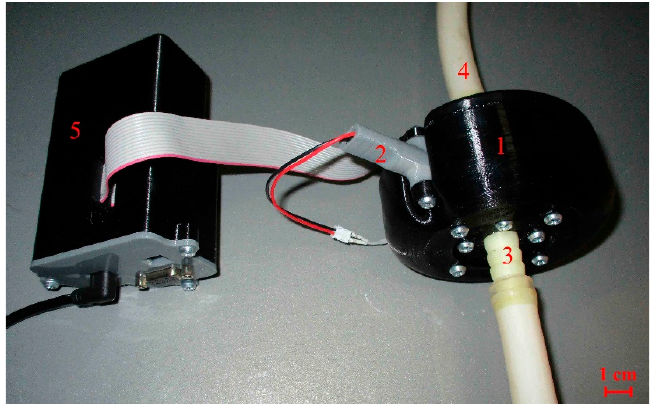
Figure 2. Photograph of the prototype sensor shown schematically in Figure 1: (1) sensor enclosure; (2) laser diode holder; (3) herringbone fitting for 14 mm hose; (4) silicone tube connected to the pumping system; (5) controller unit.